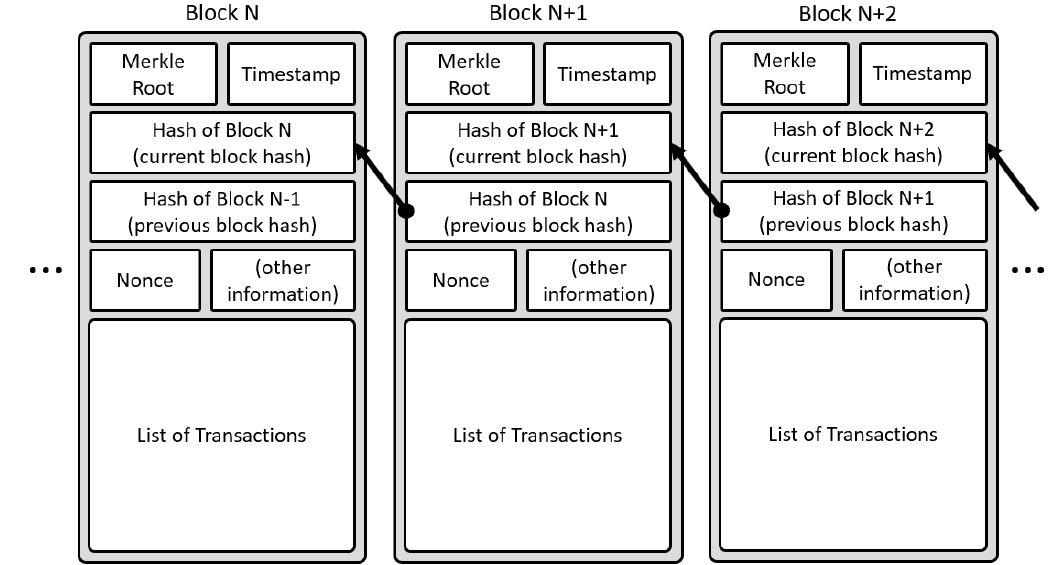
Figure 1. Structure of the blockchain.